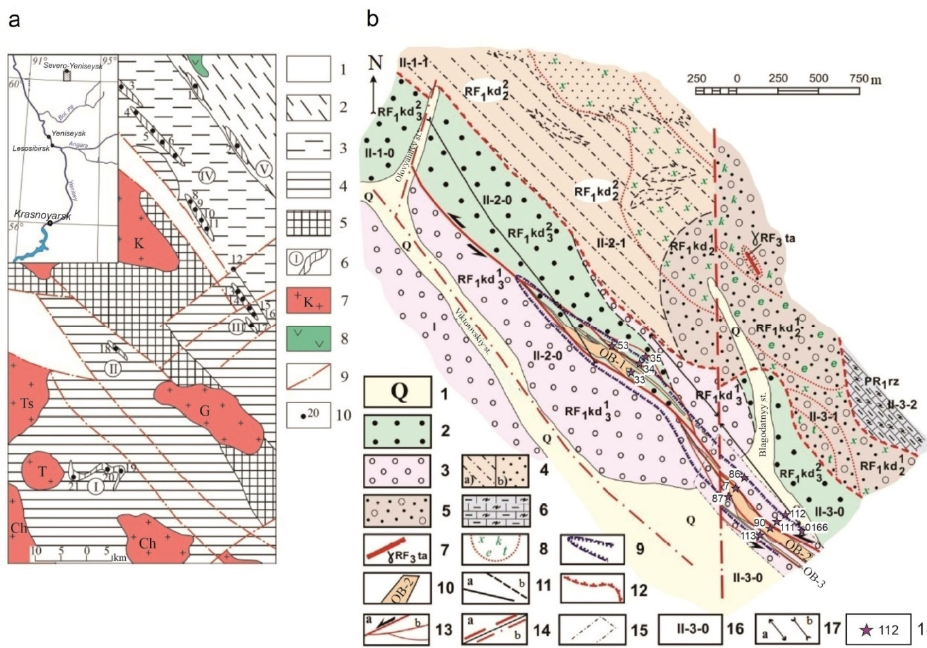
Figure 1. ( a )—Geological structure of the North-Yenisei ore region [4]; ( b )—Geological map of the Blagodatnoye deposit [24]. a: 1—deposits of the Paleozoic grabens (PZ); 2—sandy-silty-clayey rocks of cata- and metagenesis zones (RF 3 ); 3—phyllites of the Uderey and Gorbilok formations of the Sukhoy Pit Group (RF 3 ); 4—crystalline schists of the biotite zone (Sukhoy Pit Group RF 1 , Corda Group; 5—crystalline schists of epidote-amphibolite and amphibolite facies (Gorbilok and Corda formations; Penchenga Formation and Karpinsky Ridge Formation, Teya Group, PR 1 ); 6—ore zones of local dyna- mothermal metamorphism: I—Verkhnee Yenashimo, II—Blagodatninskaya, III—Perevalninskaya, IV—Aleksandro- Ageevskaya, V—Sovetskaya; 7—granitic plutons: K—Kalami, G—Gurakhta, T—Tyrada, Ch—Chirimba, Ts—Teya; 8— metamafic rocks, 9—disjunctive faults; 10—gold deposits: 1—Sovetskoye, 2—Ogne-Poteryayevskoye, 3—Skalistoye, 4—